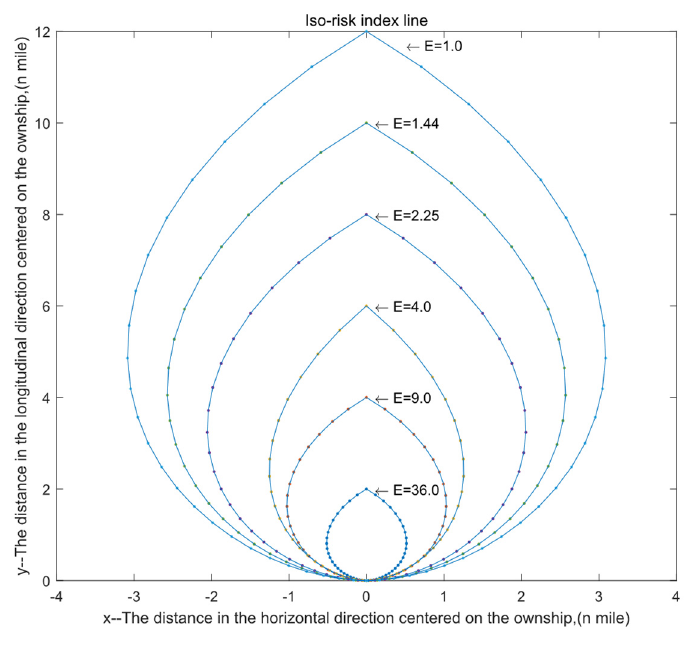
Figure 4. Isoriskigurei index line .